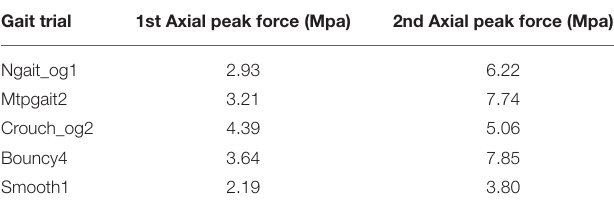
TABLE 1 | Maximum contact pressures during patient’s different gait patterns. Gait